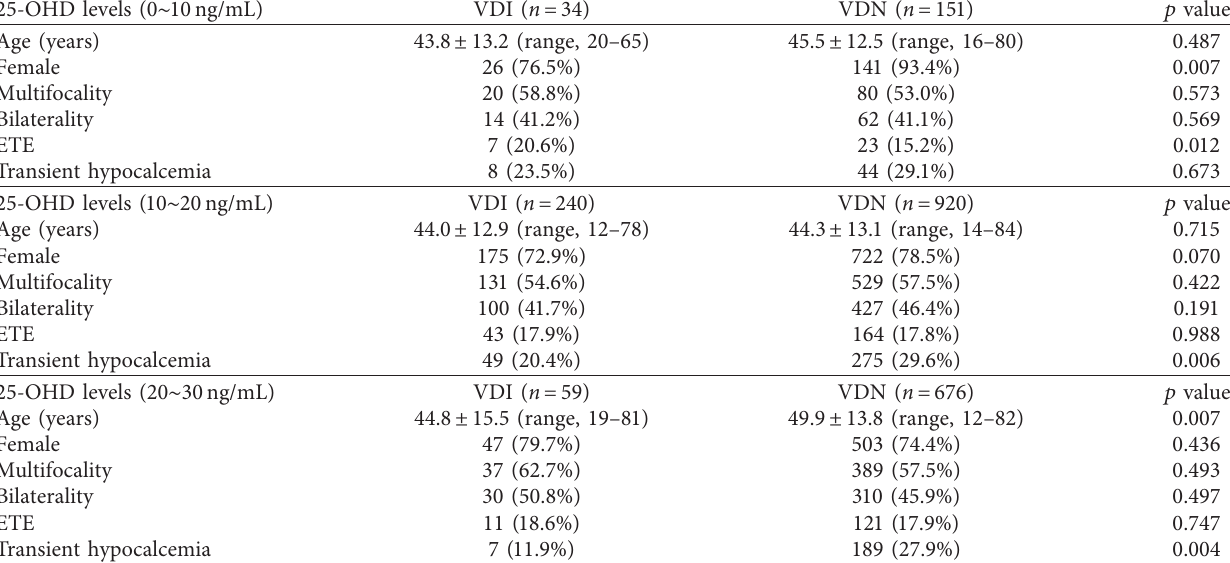
Table 6: Subgroup analysis between vitamin D3 injection (VDI) and vitamin D3 noninjection (VDN) groups according to the 25-OHD levels.